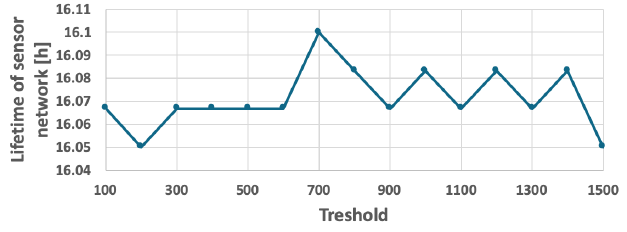
Figure 15. Calibrating the FDCR algorithm for a scenario with a variable number of detected